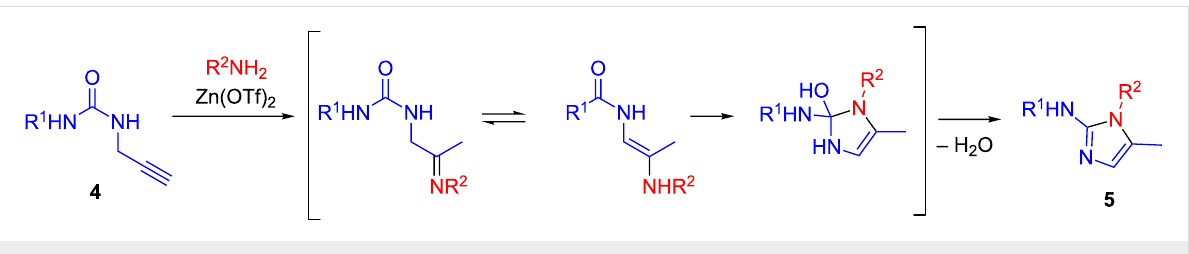
Figure 3: Plausible mechanism for the formation of 5 .